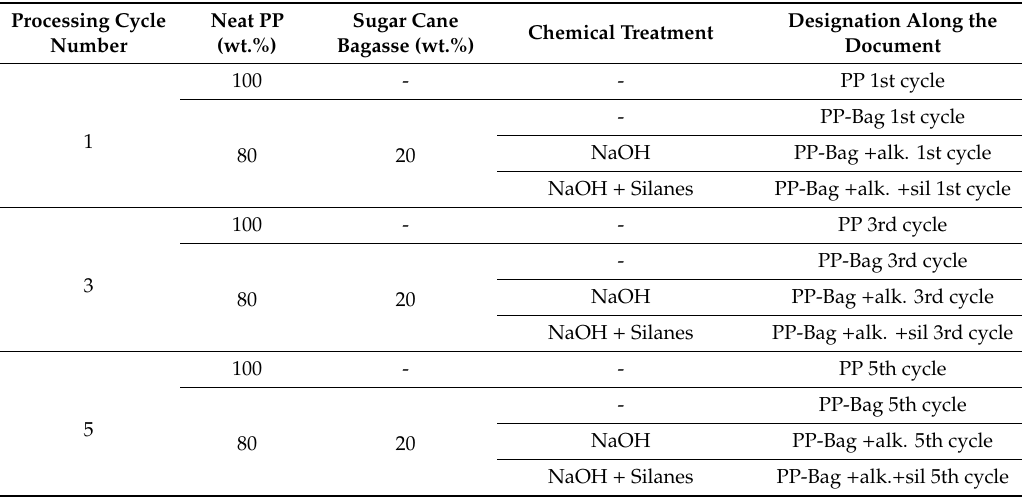
Table 1. Nomenclature of processed